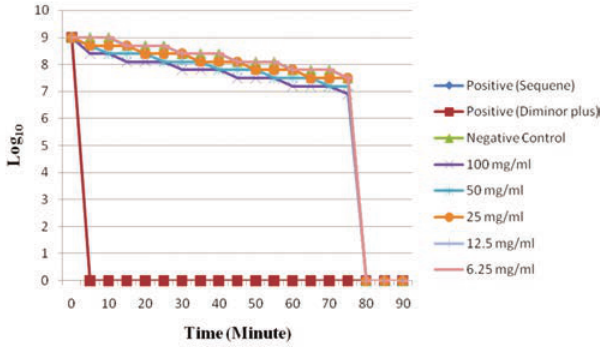
Figure 2. Chloroform Extract of Punica granatum L. against Trypanosoma